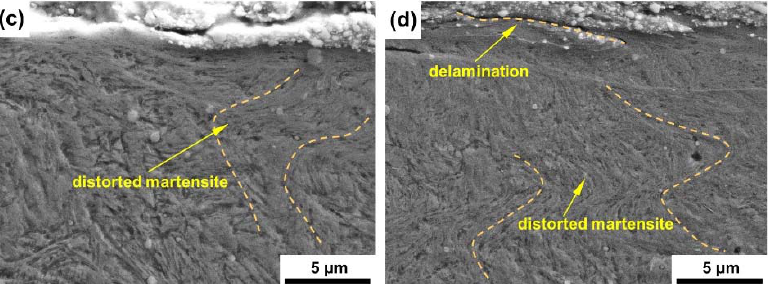
Figure 5. SEM micrographs of cross ‐ sectional microstructure of the M50 steel with different USP durations: ( a ) 0 min; ( b ) 1 min; ( c ) 5 min; ( d ) 10 min.